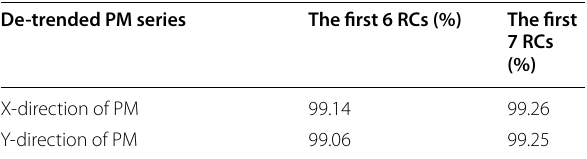
Table 2 Statistics of correlation coefficients De‑trended PM